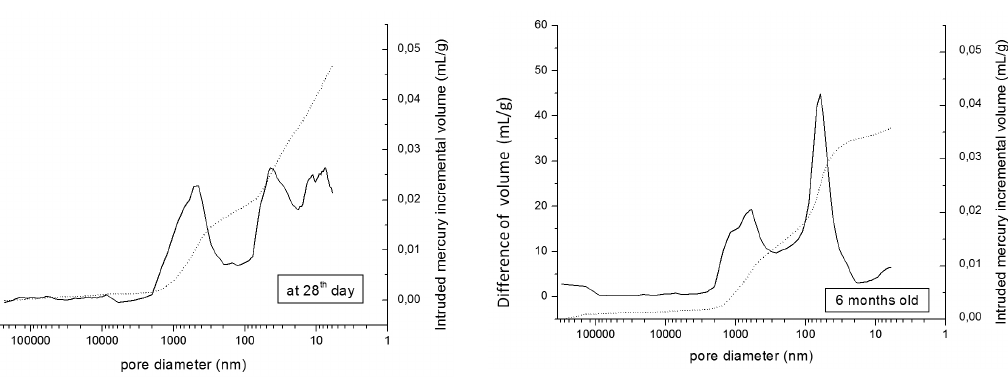
Figure 13. Porosimetry of fiber cement C at 28 days.